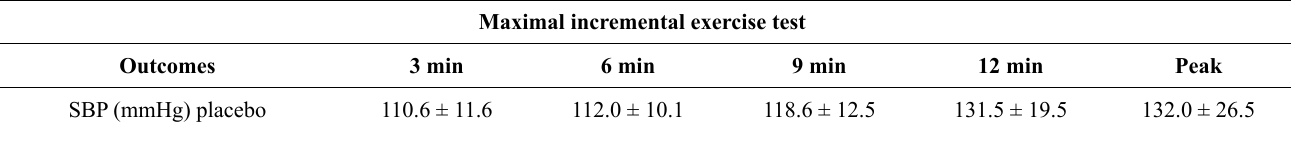
Table 3: Blood pressure response and perceived rate of effort (modified Borg scale) during maximal incremental exercise test. Maximal incremental exercise